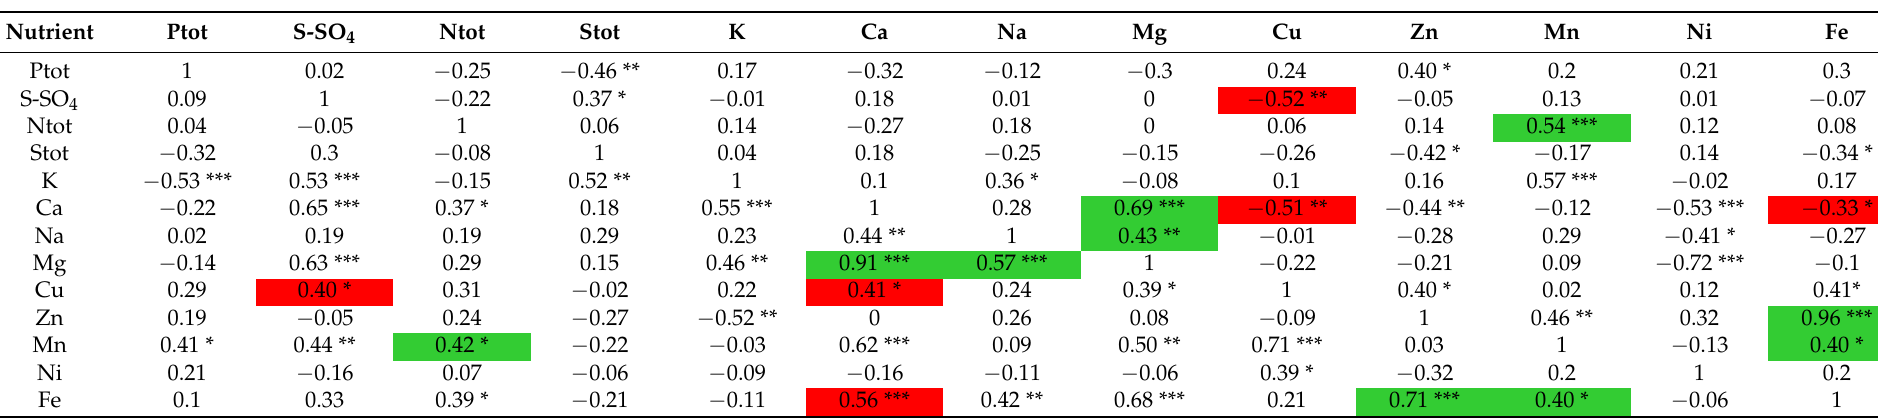
Table 4. The correlation coefficients matrix for nutrients analyzed in the vegetative stage (above diagonal) and flowering stage (below diagonal) (N =